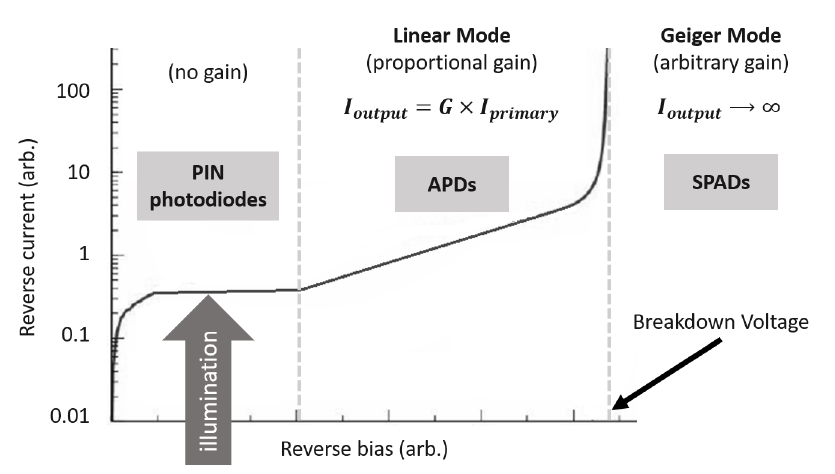
Figure 12. Schematic I-V curve in different photodetectors showing the different behaviour of gain. (b) Avalanche